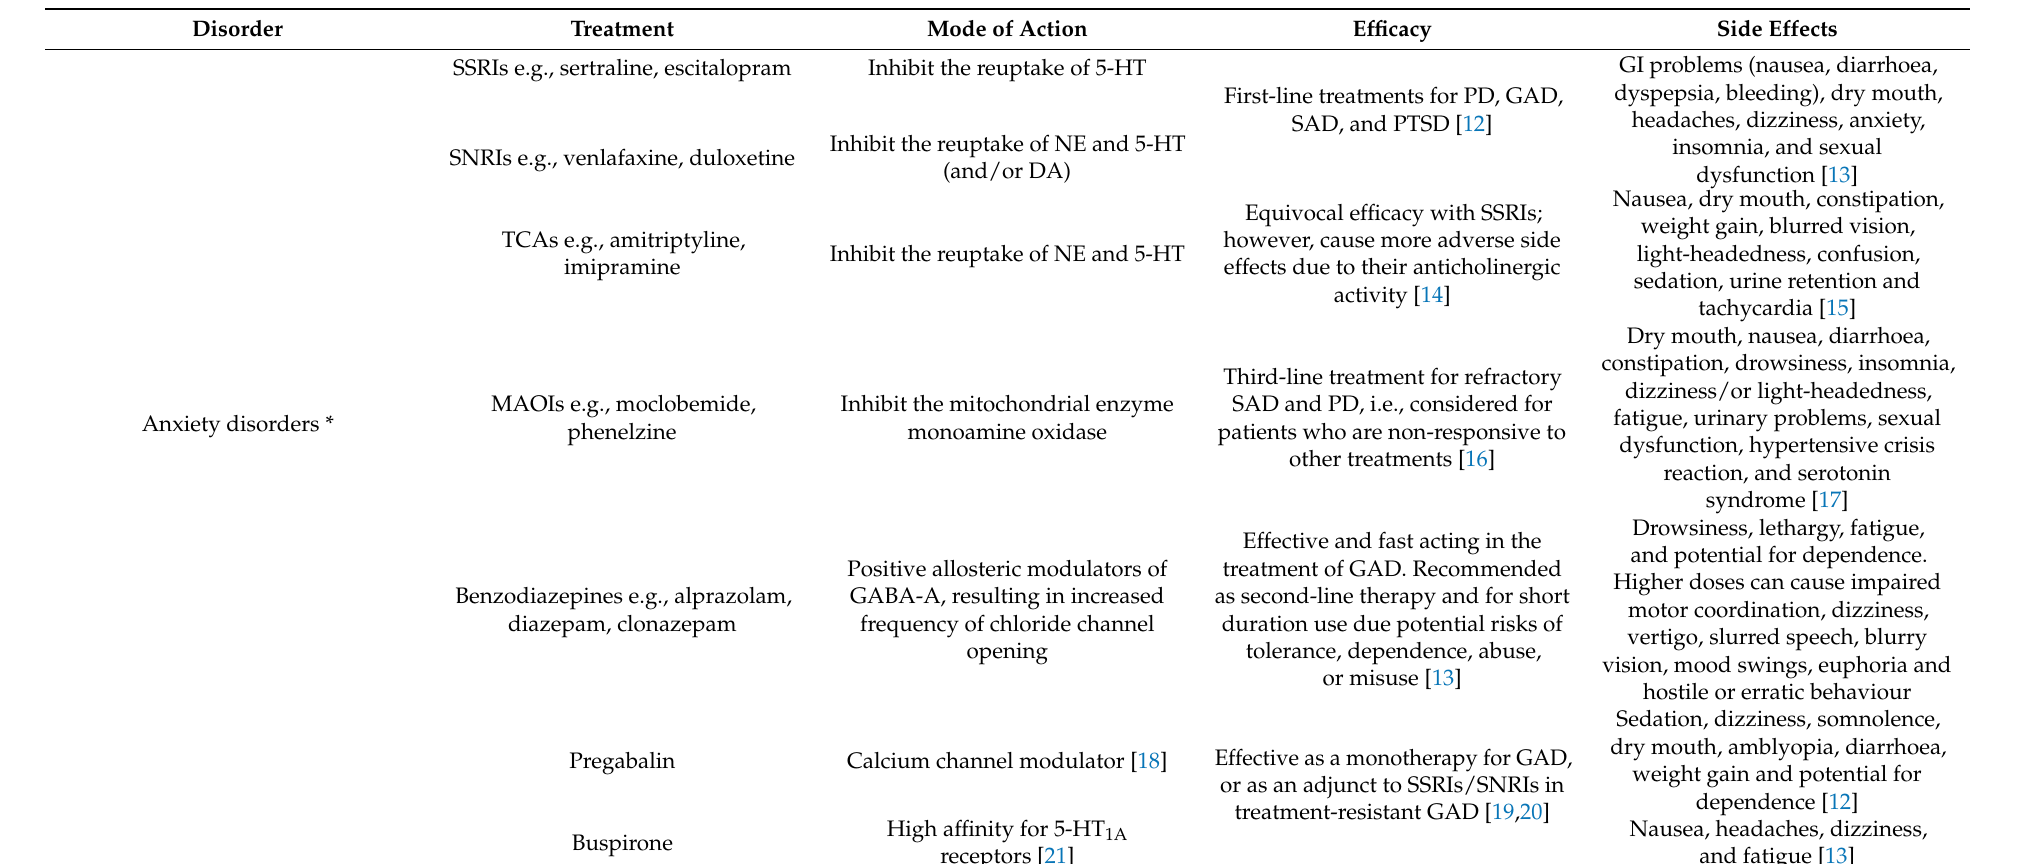
Table 1. Treatment of mental health